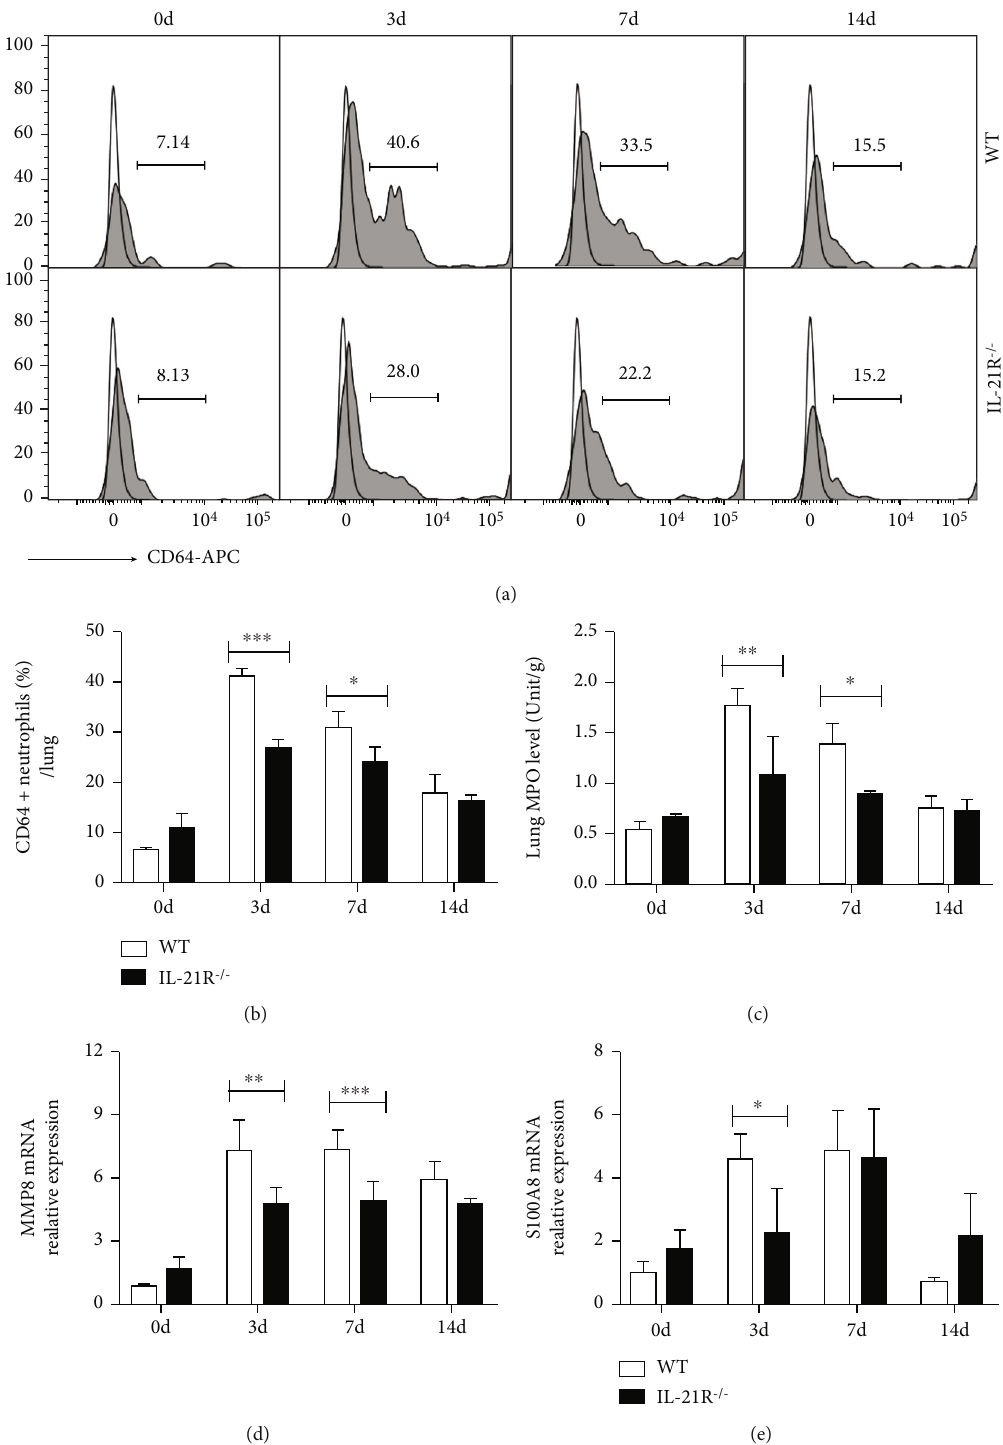
Figure 2: Pulmonary neutrophil activities of IL-21R -/- mice in response to Chlamydia muridarum ( C. muridarum ) lung infection. (a, b) The CD64 expressions (shaded histogram) with fl uorescence minus one (FMO) control (solid lines) on pulmonary neutrophils from wild-type (WT) and IL-21 receptor de fi cient (IL-21R -/- ) mice were analyzed by fl ow cytometry based on gated neutrophils as described in Figure 1(c). And the percentages of positive cells at indicated times after infection were indicated. (c) The myeloperoxidase (MPO) activity in the lung tissues at days 0, 3, 7, and 14 p.i. (d, e) The mRNA expression of matrix metalloproteinase 8 (MMP8) and S100A8 after C. muridarum infection was detected by quantitative real-time PCR (qPCR). Data are represented as means ± SD from n = 3 – 4 per group, representative one of three independent experiments. Statistical signi fi cances of di ff erences are determined by two-way ANOVA followed by Bonferroni ’ s multiple comparisons test. ∗ P < 0 : 05 , ∗∗ P < 0 : 01 , and ∗∗∗ P < 0 : 001